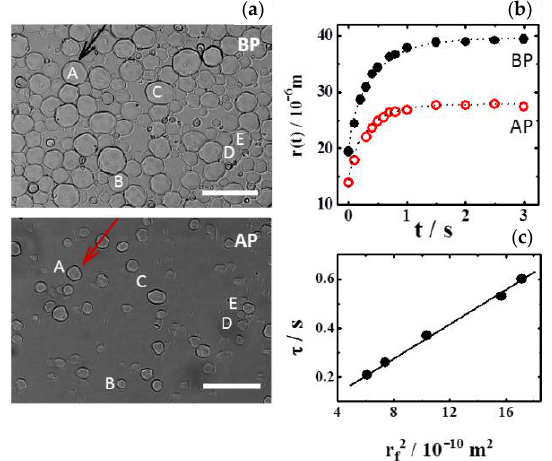
Figure 2. Plots of 𝑙𝑛(𝑟 𝐵𝑃2 − 𝑟 𝐴𝑃2 ) = 𝑙𝑛(Δ𝑚𝜉 4𝜋𝜌 0 ⁄ ) + 𝜉𝑟 𝐵𝑃 as a function of 𝑟 𝐵𝑃 , from which the density relaxation- length ξ is determined. Particles A to D used in experiments are labeled in Figure 3a.